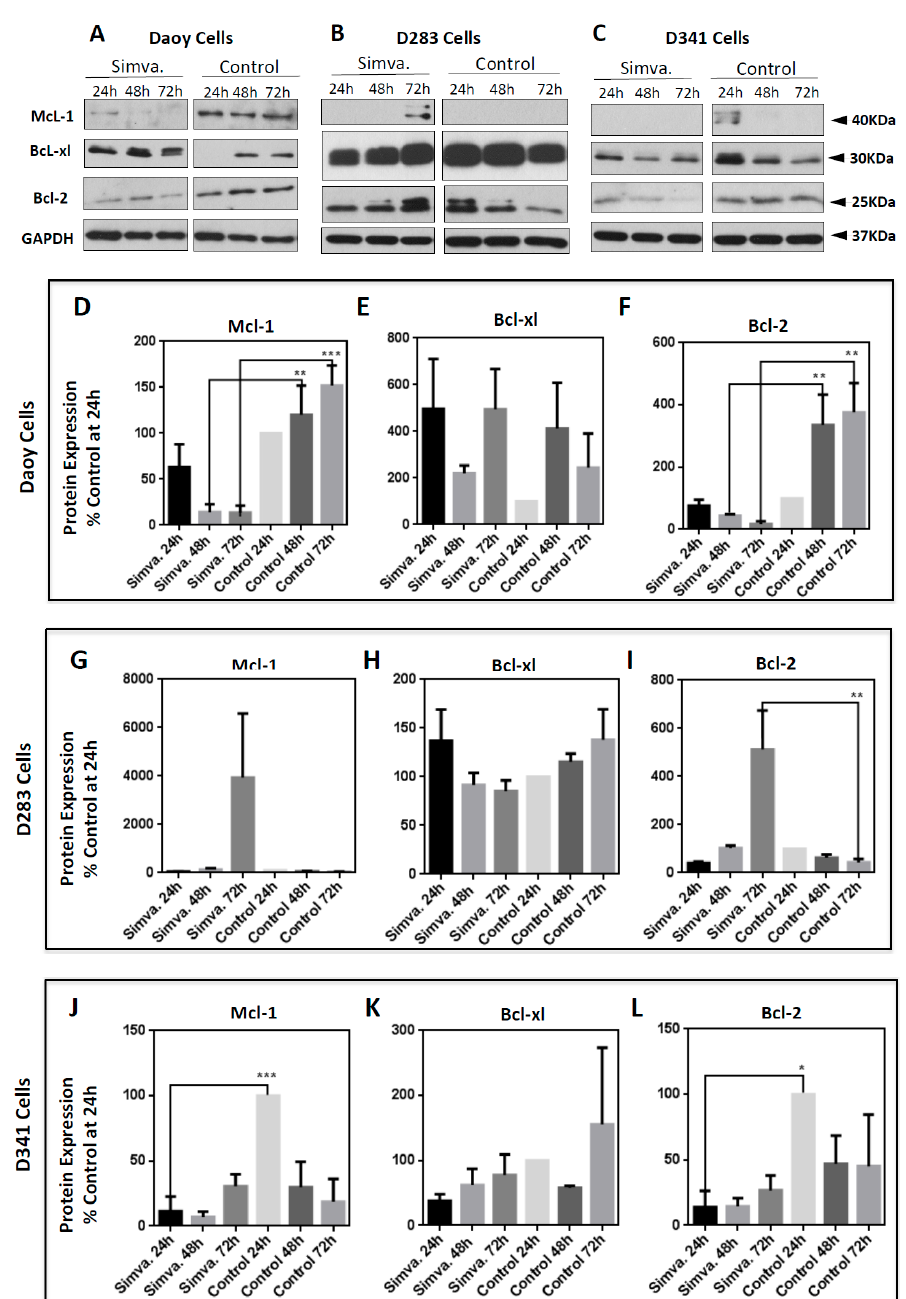
(Figure 8B,E) or D341 cells (Figure 8C,F). In summary, these findings suggest the involvement of pro-